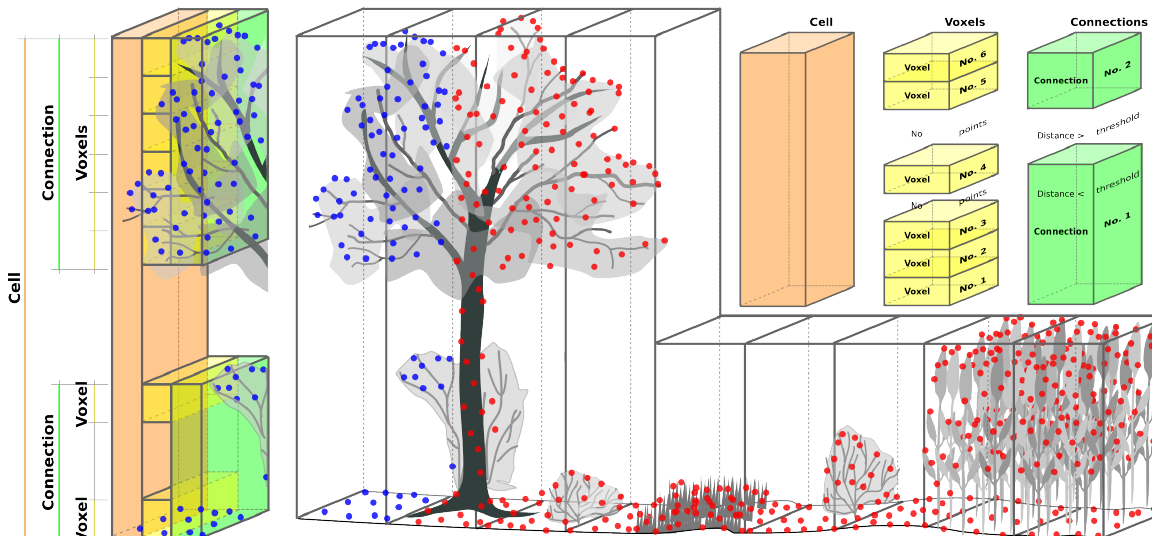
Figure 2: Schema of the cell-, voxel- and connection-level related to a generalized ALS point cloud for different vegetation structures Roughness class Rule-base Vegetation type 0.045 max. height(lowest connection) < 0.15 streets, short grassland 0.050 max. height(lowest connection) > 0.15 AND < 0.25 grassland, agricultural area shrubs reed number of connections > 1 AND max. height(cell) < 10.00 small trees number of connections > 1 AND max. height(cell) > 10.00 forest Table 1: Rule-base for hydraulic roughness